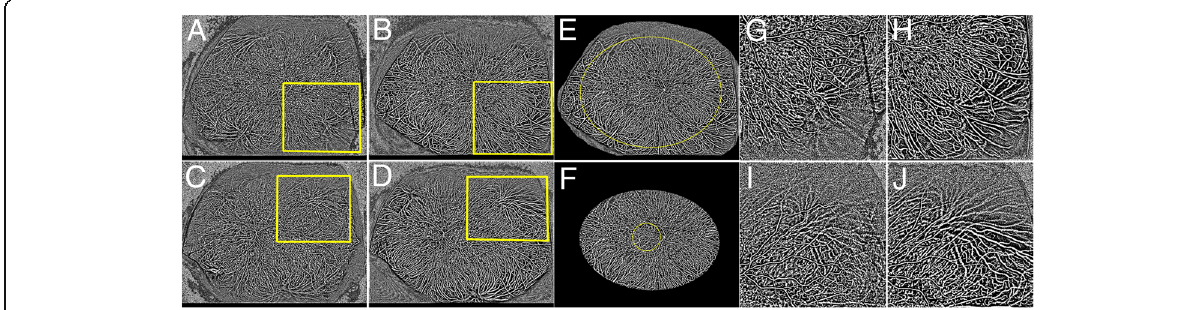
Fig. 6 Binarized images of wide-field indocyanine green angiograms before and after treatment. a Baseline image in the right eye. b Posttreat- ment image in the right eye. c Baseline image in the left eye. d Posttreatment image in the left eye. e , f Densitometry of retinal and choroidal vessels. e The same image as b . The yellow oval is drawn through one-disc diameter posterior to the center of the ampullas of vortex veins. f Trimmed image along the yellow oval on e . The yellow circle indicates posterior area within 3 mm from the fovea and the outside of that was considered as the mid-periphery. g , h Magnified images of the yellow square in a or b . i , j Magnified images of the yellow square in c or d . After the therapy, the choroidal vessels were clearly visualized and the narrowed vessels in the acute phase resolved in both eyes